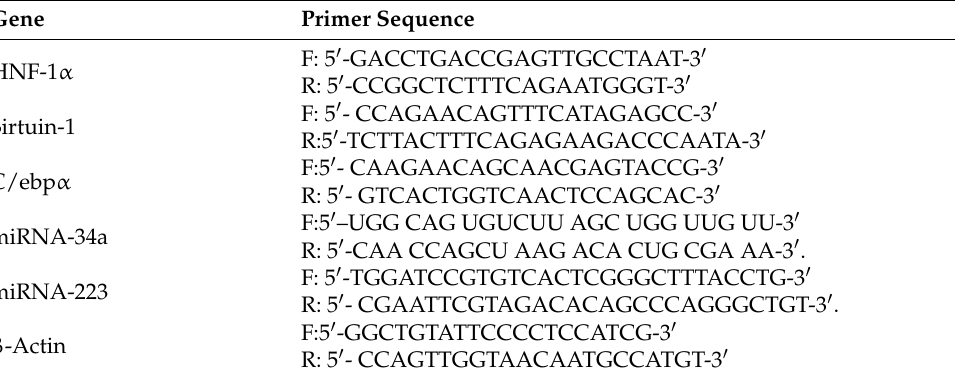
Table 4. Primers used in real-time